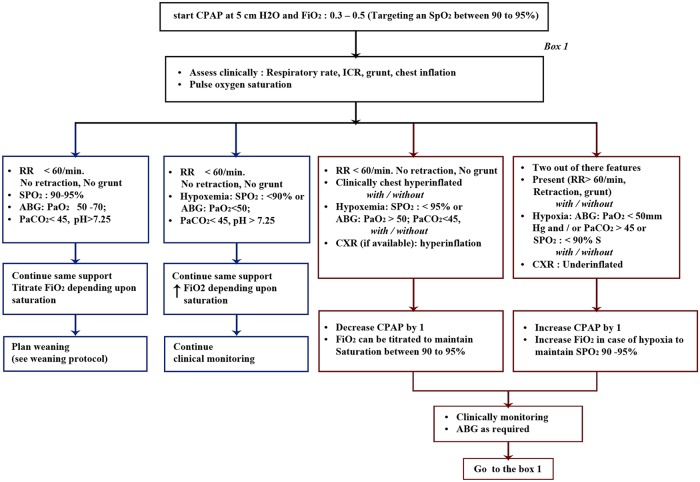
Clinical trial protocol for titration, weaning and removal of CPAP.